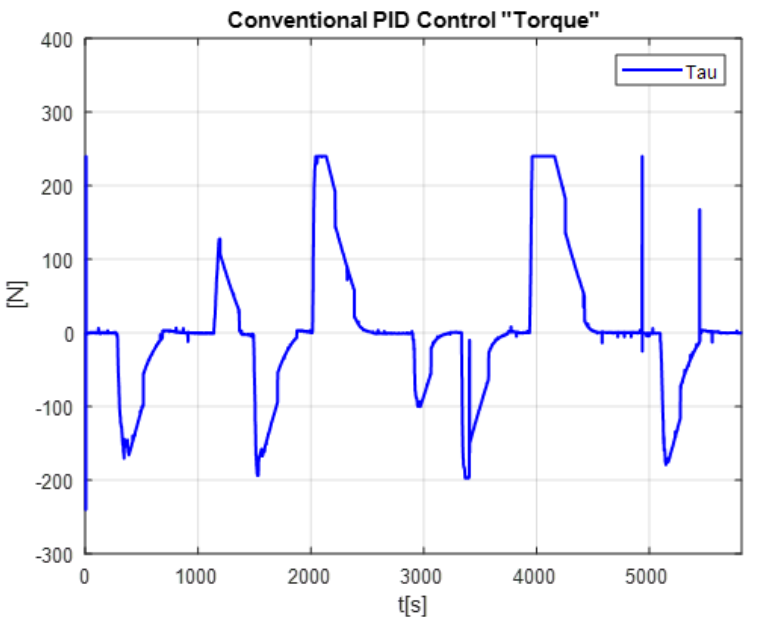
Figure 14. PID Controller without the disturbance.